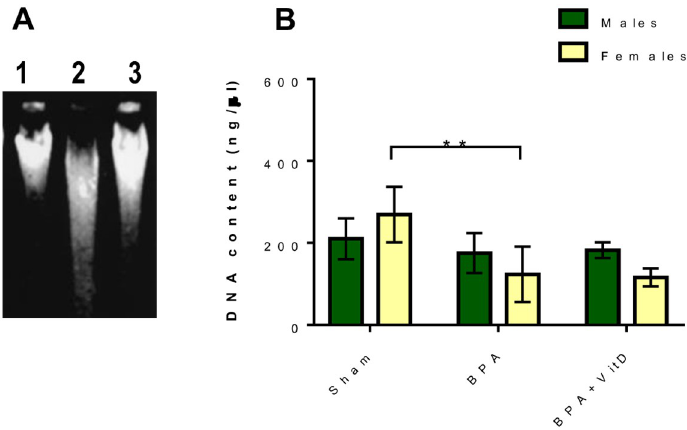
Fig 8. VitD reduces the genomic DNA integrity in BPA-treated mice. (A) Agarose gel electrophoresis of DNA isolated from the splenic tissues of control (lane 1), BPA-treated (lane 2), and BPA+VitD-treated (lane 3) mice. Data are represented as mean ± SD (n = 12), and P < 0.01 is